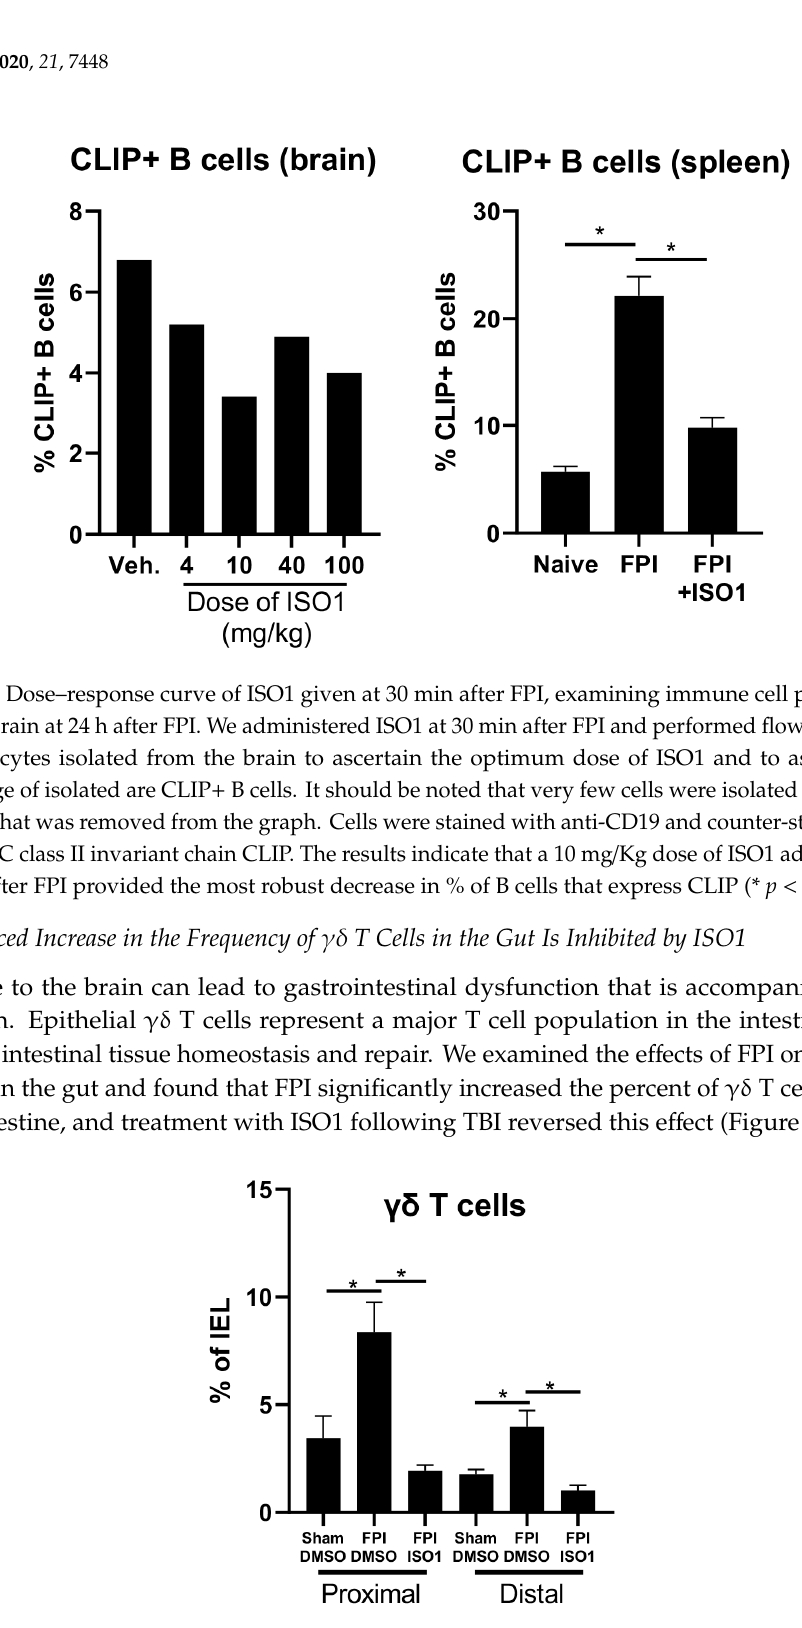
Figure 4. Effects of ISO1 on the frequency γδ T cells on the gut after FPI. We administered ISO1 using 10 mg/Kg at 30 min after FPI, and performed flow cytometry on leukocytes isolated from either proximal or distal intestine 24 h following FPI to assess what percentage of isolated leukocytes are γδ T cells. T cells were stained with anti-CD3 antibody and counter-stained with anti- γδ antibody. The percent of T cells that are γδ T cells are significantly increased in the gut after FPI. One way ANOVA * p < 0.05. N = 6 per group, error bars = SD.